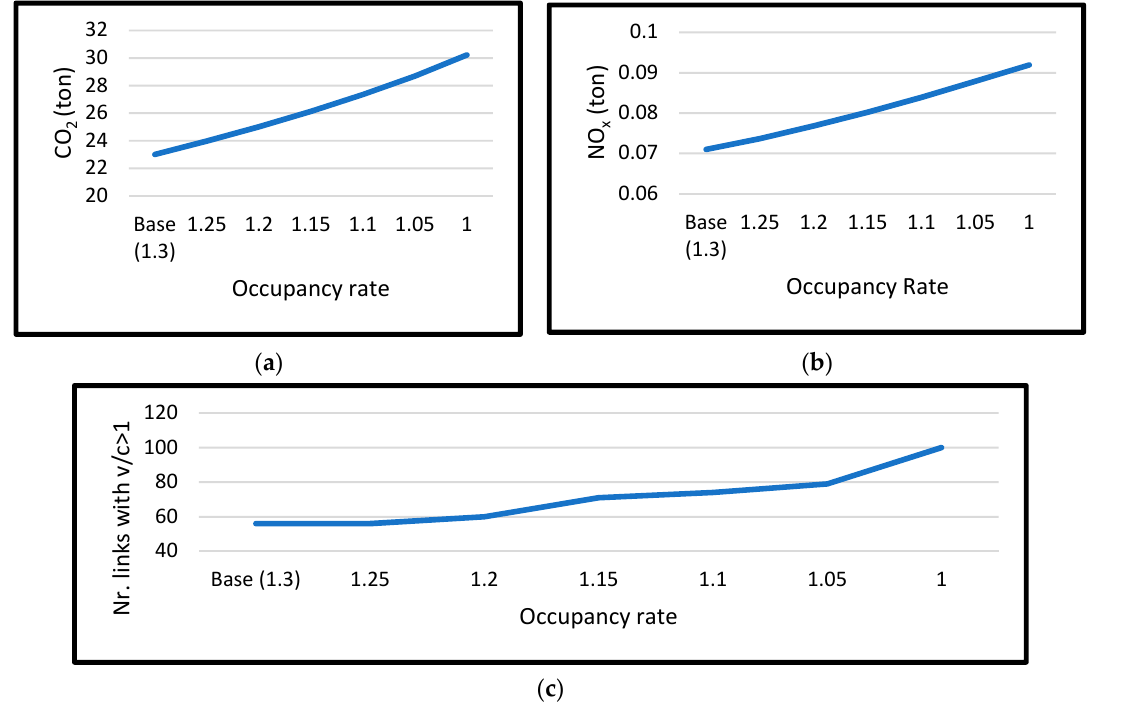
Figure 5. Results regarding scenario (2): ( a ) CO 2 ton; ( b ) NO x ton, and ( c ) number of links with a V/C ratio greater than 1. Peak-hour period. Table 3. CO 2 and NO x emissions growth rate for scenario